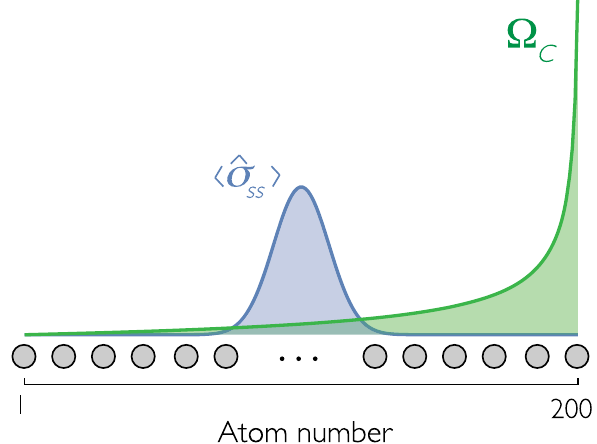
FIG. 17. Schematic of the spatial profile of the control field ffiffiffiffiffiffiffiffiffiffiffiffiffiffiffiffiffiffiffiffiffiffiffiffiffiffiffiffiffi p Ω ∼ z N= ð N þ 1 − j Þ (green curve, arb. units) for a chain of c ð j Þ N ¼ 200 atoms. The initial spin wave, given by Eq. (29), is overlaid in blue.